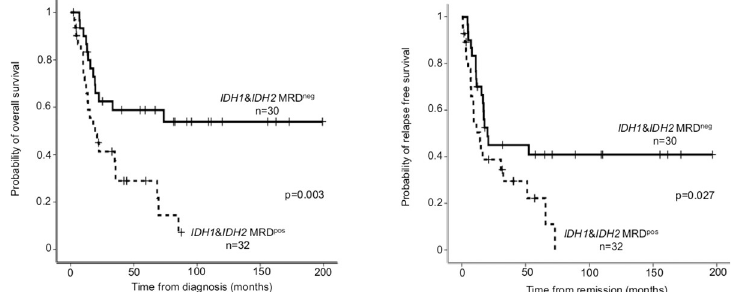
Fig 6. Overall survival and relapse free survival according to IDH1/2 MRD after induction. On both panels (A: overall survival; B: relapse free survival) IDH1/2 MRD negativity defined as VAF < 0.2% and MRD positivity as VAF > 0.2%.